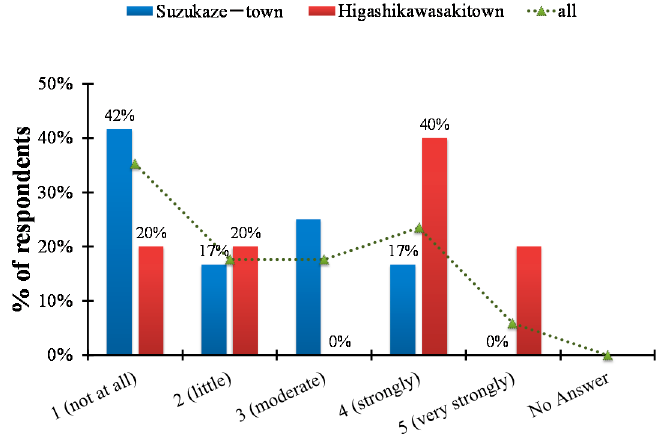
Figure 11. Distribution of the opinion of respondents regarding whether they thought a storm surge was a real danger for them (n = 5 for Higashi-Kawasaki town, n = 12 for Suzukaze town).